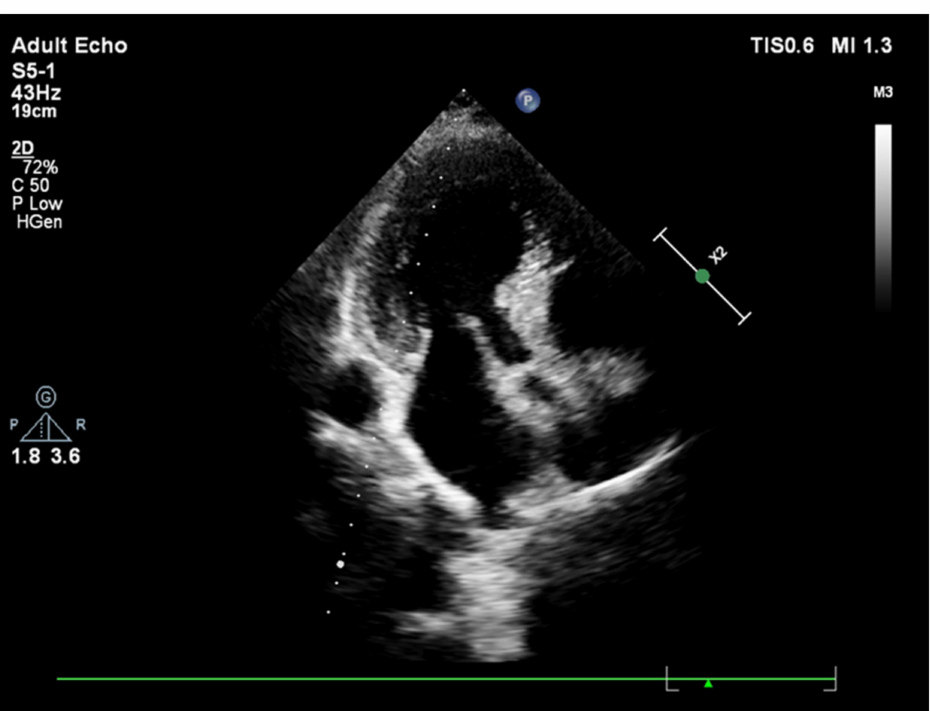
Figure 2. A sharp curvature of more remarkable basal septal hypertrophy from apical 4 chamber view during end-diastole in another hypertensive patient.